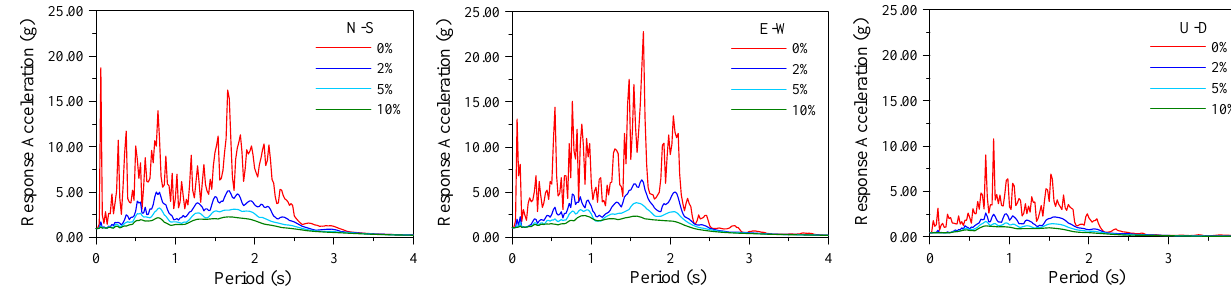
Fig. 6. Response spectrums of Bala (Ankara) Earthquake on 20 December 2007.